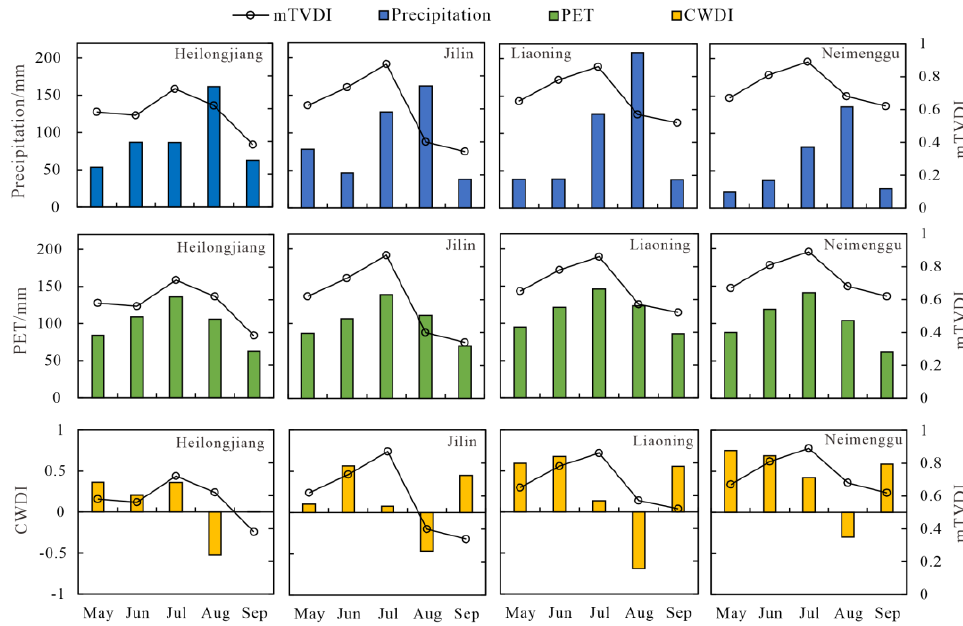
Figure 10. Comparison of the mTVDI with precipitation, PET, and the CWDI during the growing season (May−September) of 2017. season (May − September) of